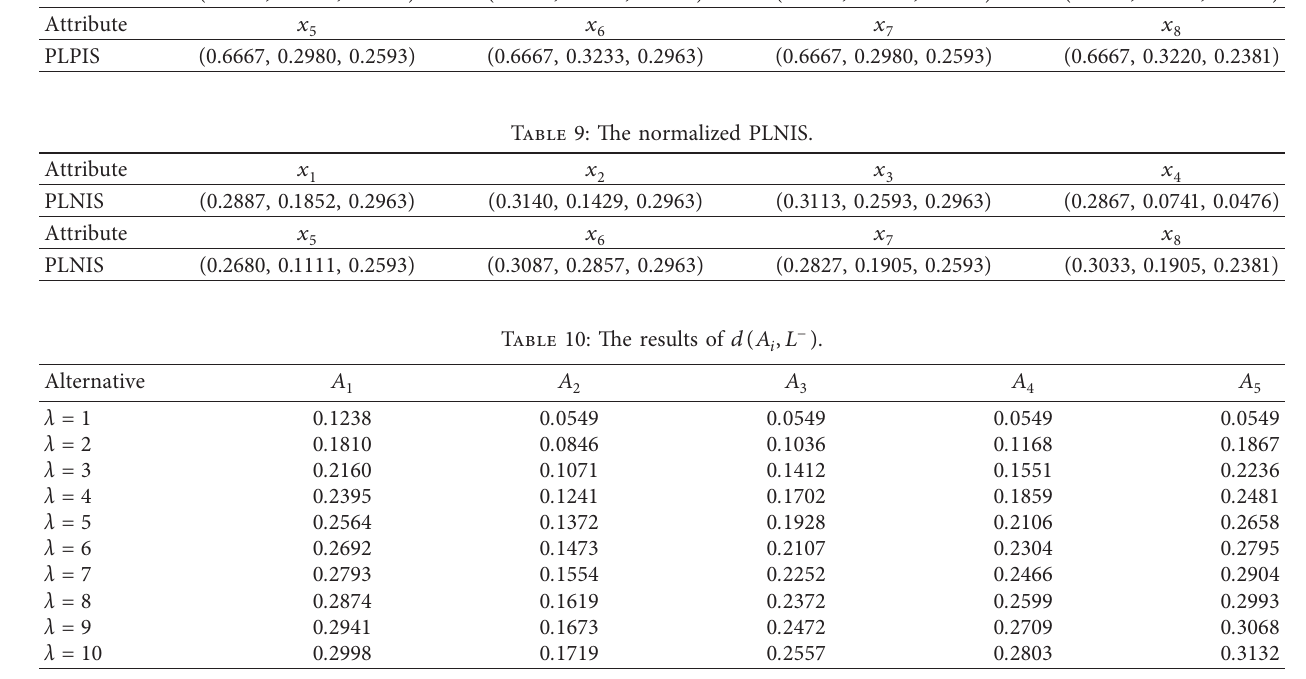
Table 11: The results of d ( A